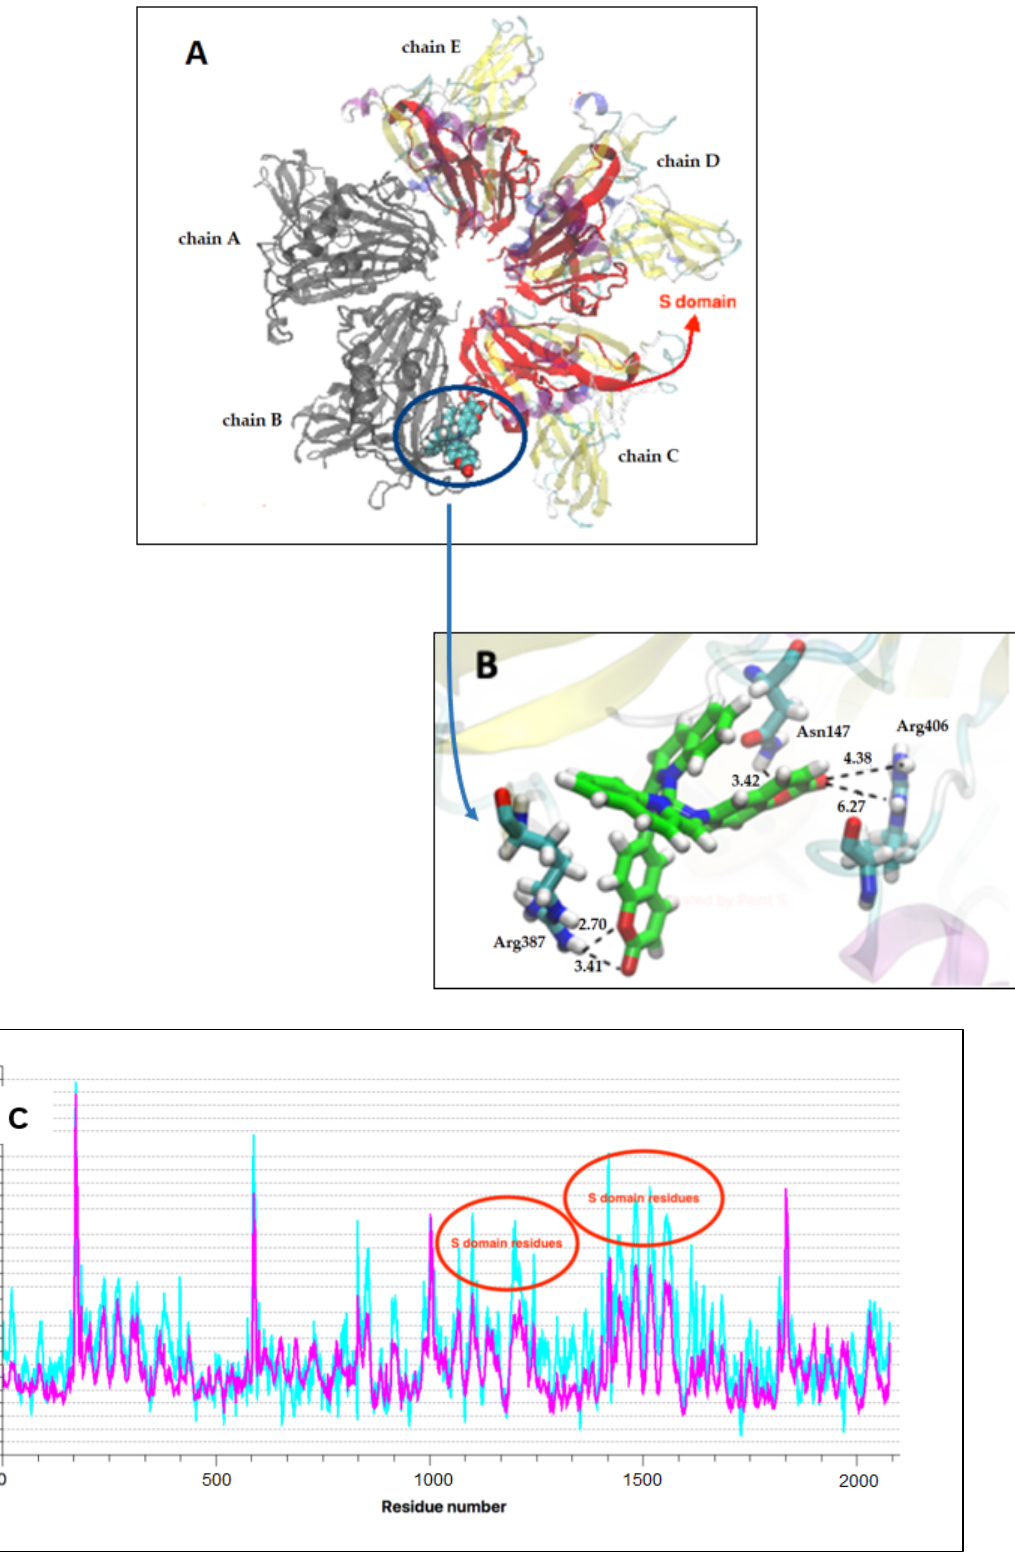
Figure 4. ( A ) 3D representation of the chains (colored) and S domain (red) affected by ligand binding (colored); ( B ) binding interaction between complex and protein; ( C ) RMSF profile between initial state (fuchsia) and final state (blue light) and their corresponding residues.